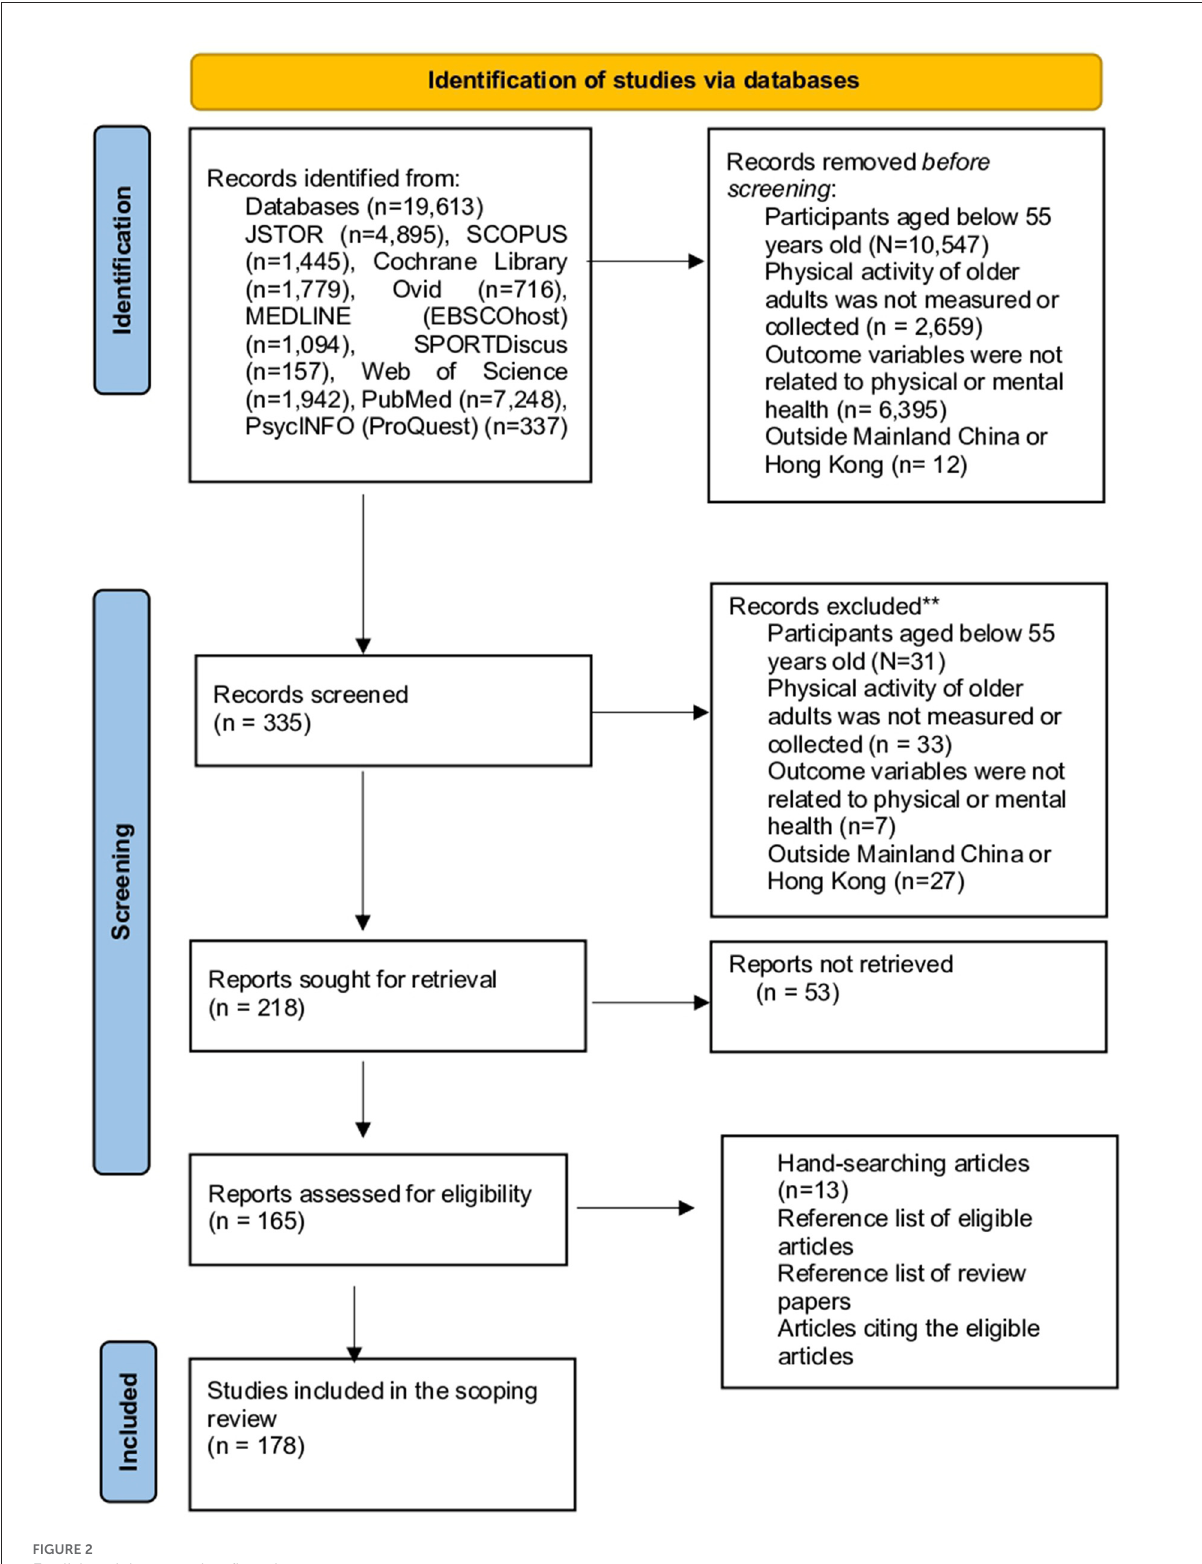
FIGURE2 English article screening